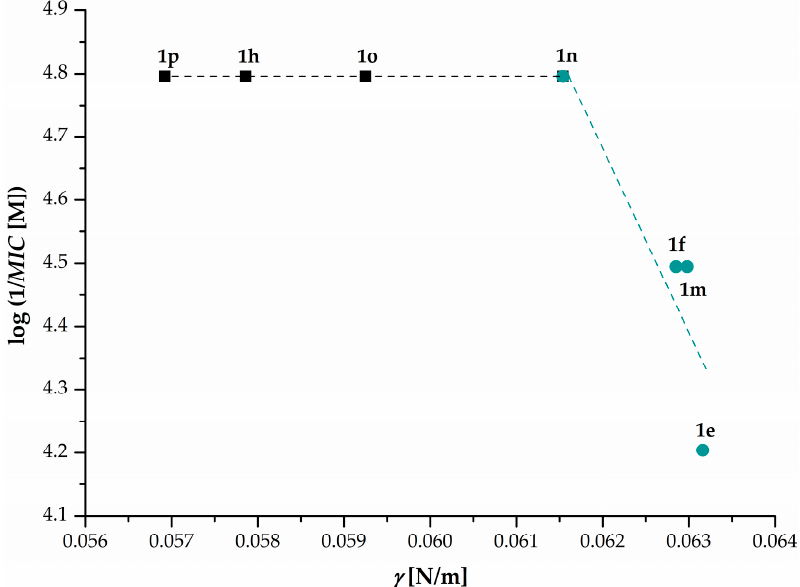
Figure 7. Bilinear relationship between the γ (in N/m units) and log (1/ MIC [M]) parameters resulting from 21-d in vitro screening of the 3-alkoxy substituted compounds 1e – h and 1m – p (alkoxy = butoxy to heptyloxy) against MA 330/80.